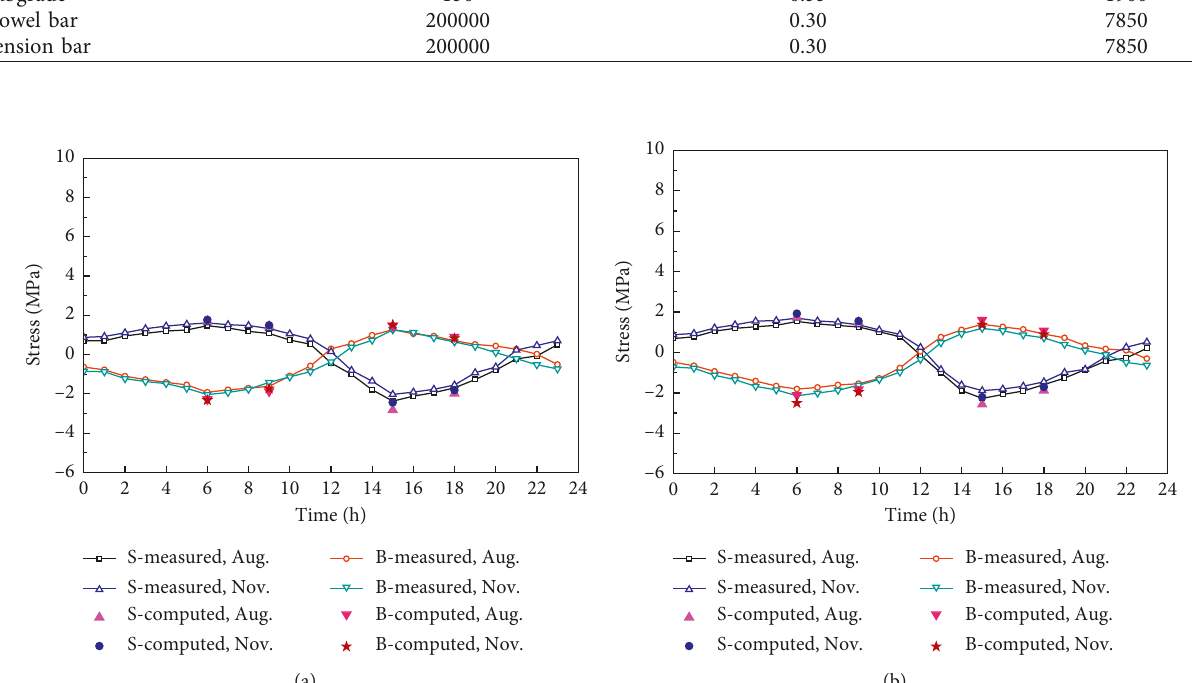
Figure 6: Measured and computed stresses in the concrete slab. (a) Stresses in the longitudinal direction. (b) Stresses in the transverse direction.